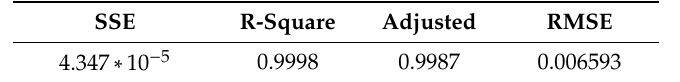
Table 3. The fitness of the curve.